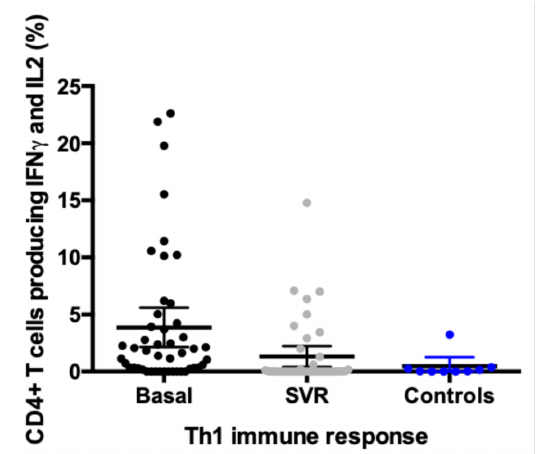
Figure 1. Distinctive Th1 immune response before and after treatment and compared to healthy controls. Intracellular cytokine staining in CD4+ T cells. Data represented as percentage of double positive IFN + IL2 expressed as mean (95% CI): basal expression 3.87 (2.15–5.59); SVR week +48 expression 1.32 (0.41–2.23); healthy controls expression 0.46